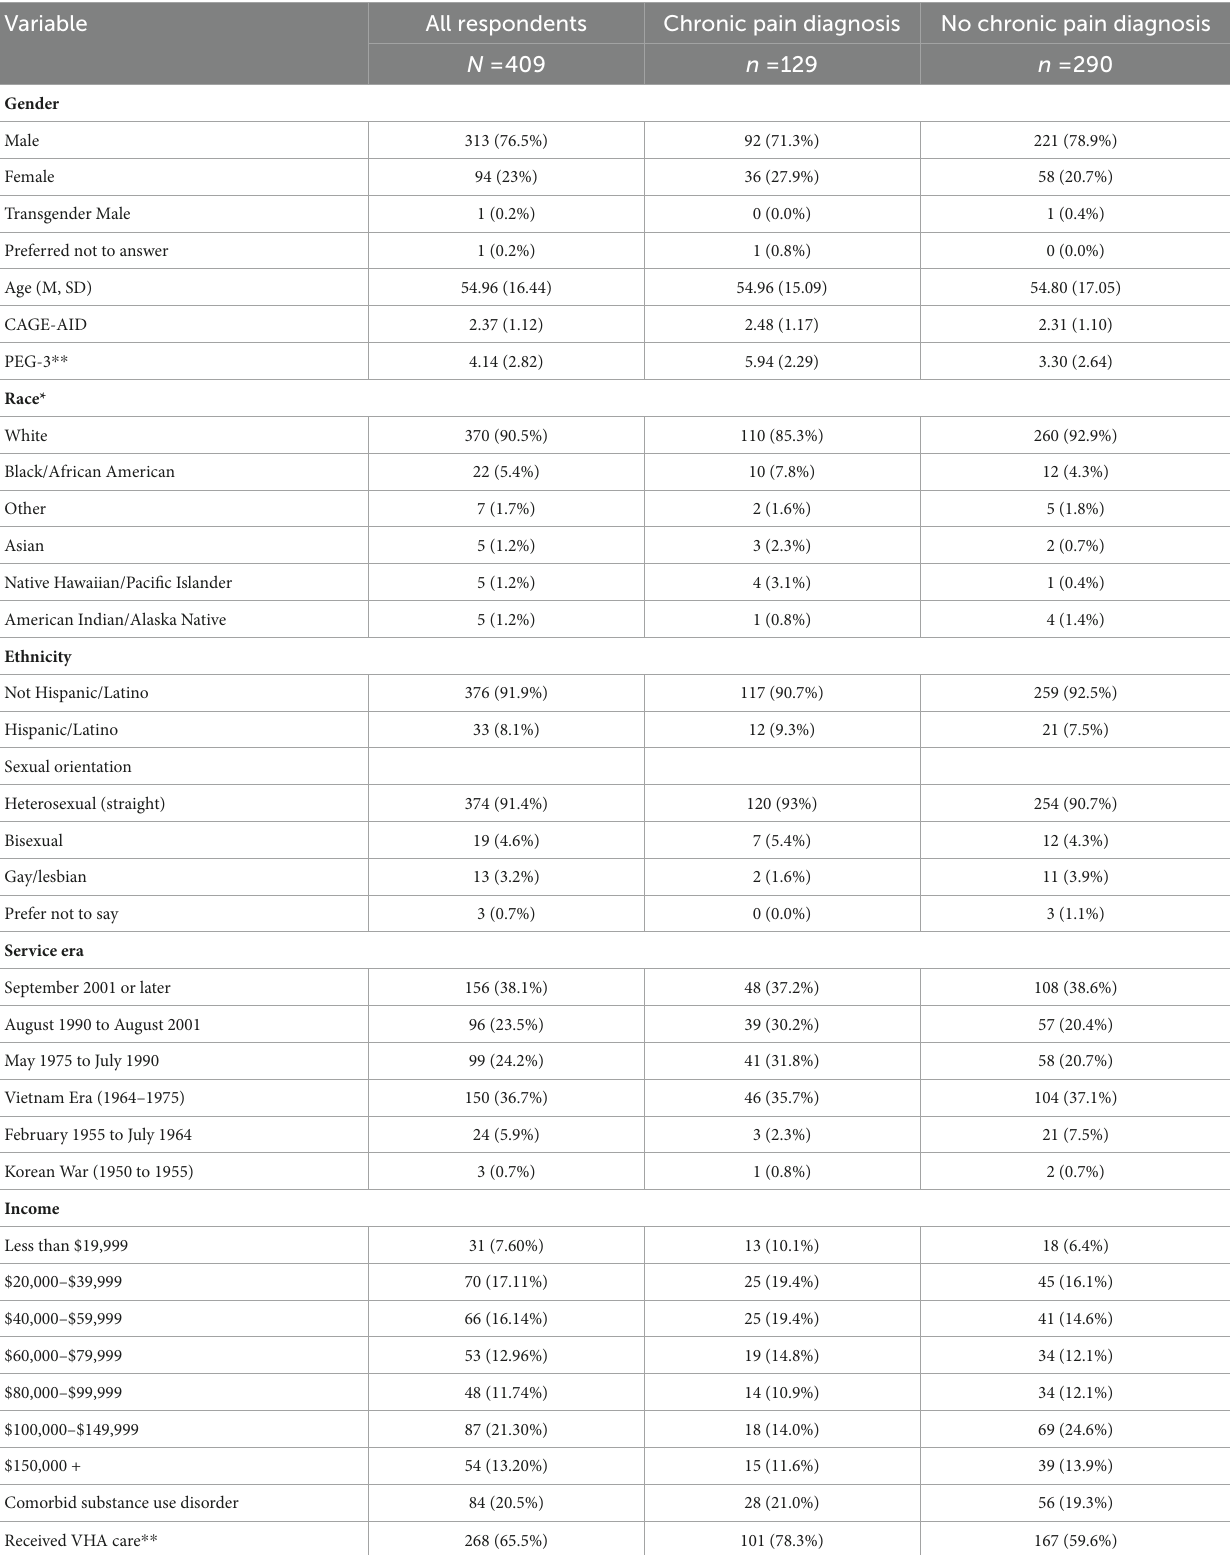
TABLE 1 Sample demographics by chronic pain diagnosis category (N =